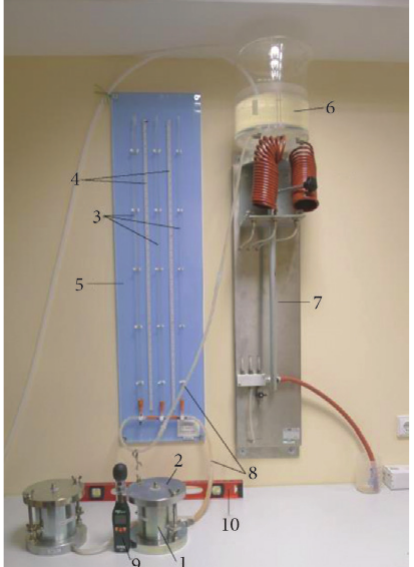
Fig. 2. Falling Head Permeameter scheme: 1 –